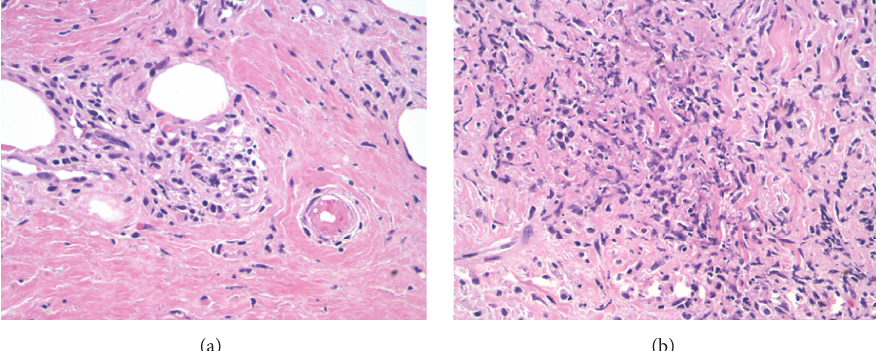
Figure 6: (a) Higher magnification of nodular areas. Leukocytoclasis is evident by the presence of vascular damage caused by nuclear debris from infiltrating neutrophils. Magnification 200x. (b) An earlier example of leukocytoclasis where the contour of the small vessel is still evident (arrow). Magnification 400x.